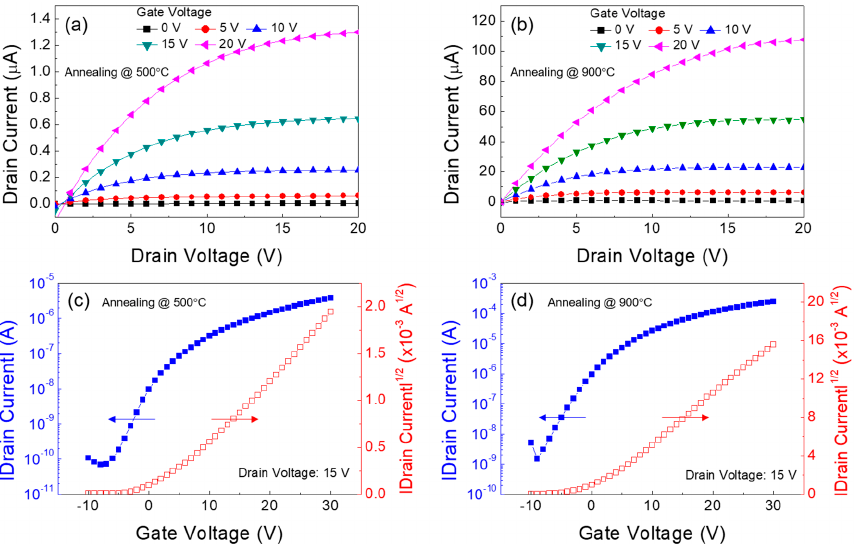
Figure 8. Output characteristics of the Ga:Sn oxide TFTs fabricated at the annealing temperature of ( a ) 500 °C and ( b ) 900 °C. Transfer characteristics of the TFTs fabricated at the annealing temperature of ( a ) 500 °C and ( b ) 900 °C.